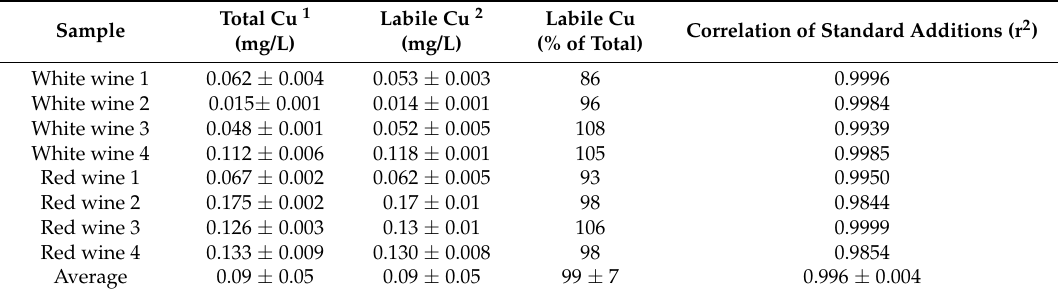
Table 1. Total and labile Cu concentrations in pretreated wines and the correlation of the standard additions